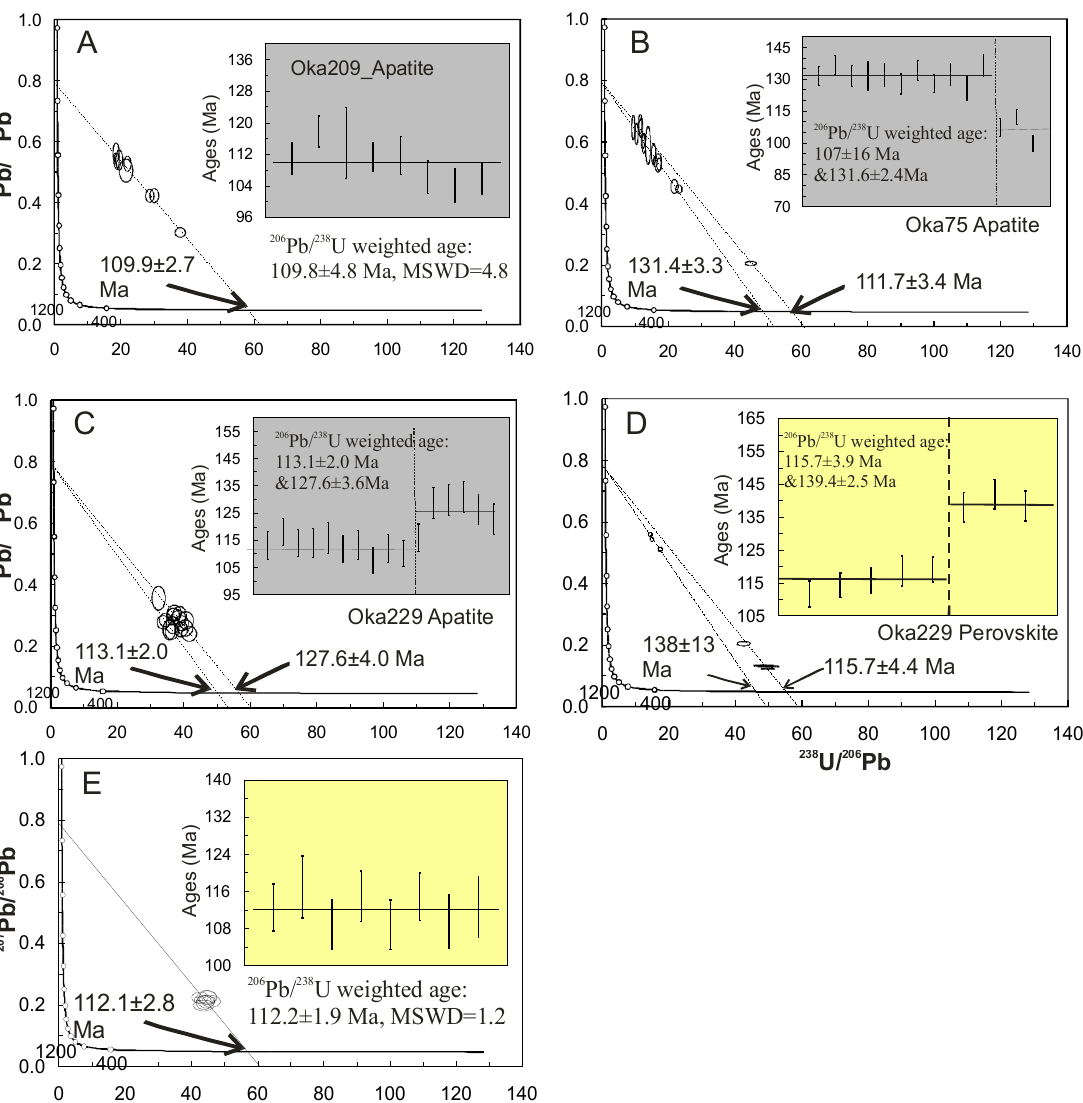
Figure 10. U-Pb isotopic ages for apatite and perovskite from the Oka carbonatite complex. Examples are illustrated for samples with a single age for apatite ( A ) and bimodal age distributions ( B , C ). Diagrams ( D ) and ( E ) illustrate examples of perovskite age results, ( D ) gives a bimodal distribution age and ( E ) yields a single young age. All reported uncertainties are at 2 σ level as determined by Isoplot [46]. The Mean Square Weighted Deviation (MSWD) is used as a statistical validity of the regression line according to the criteria defined by Wendt and Carl